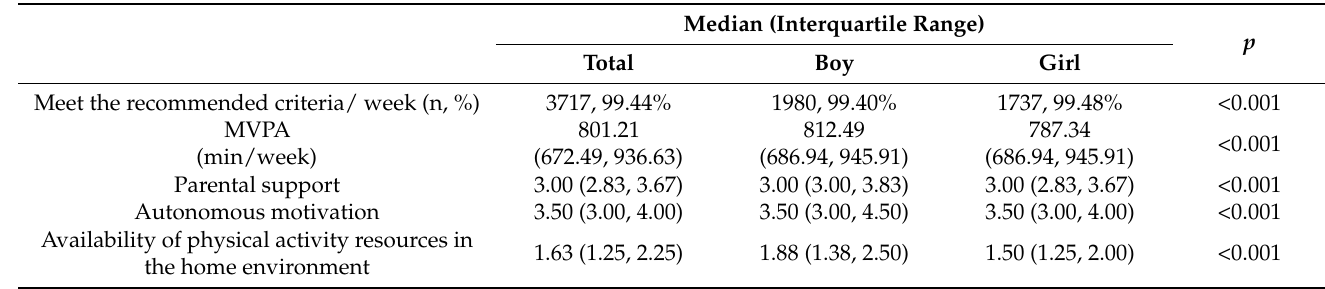
Table 2. Descriptive statistics of moderate to vigorous physical activity, parental support, availability of physical activity resources in the home environment, and autonomous motivation by